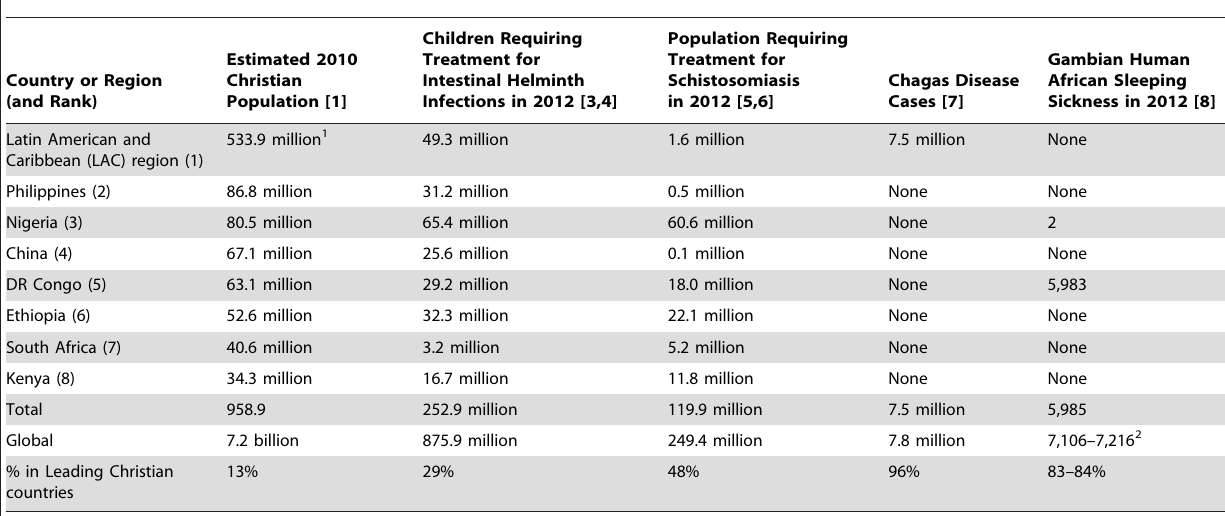
Table 1. NTDs and global christianity.